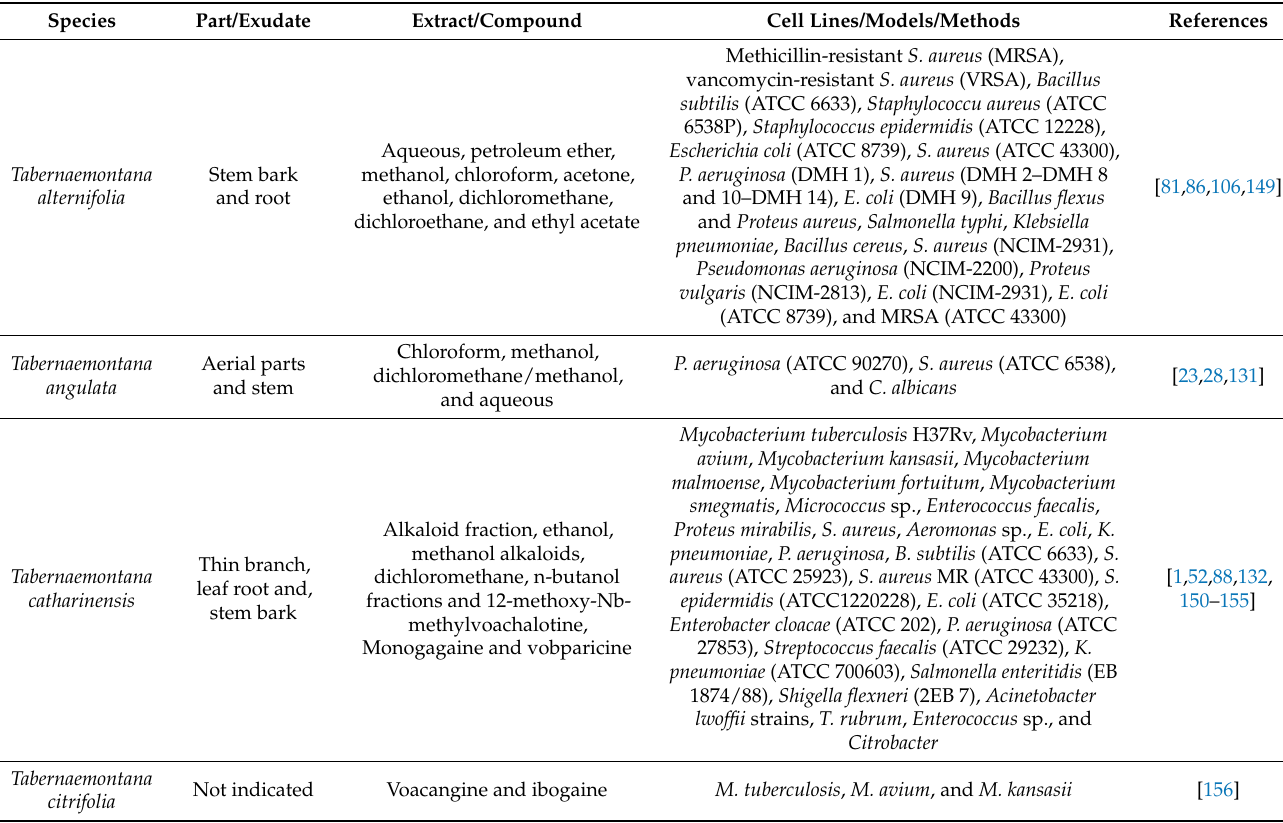
Table 6. Antibacterial activities of extracts and compounds isolated from Tabernaemontana